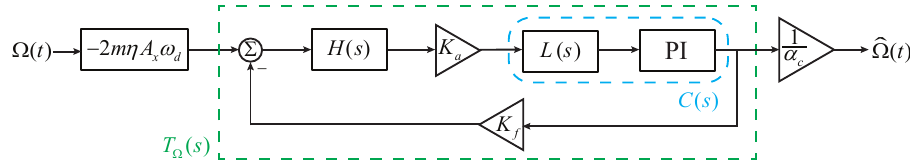
Figure 3. The equivalent block diagram of the force-rebalance sense channel.